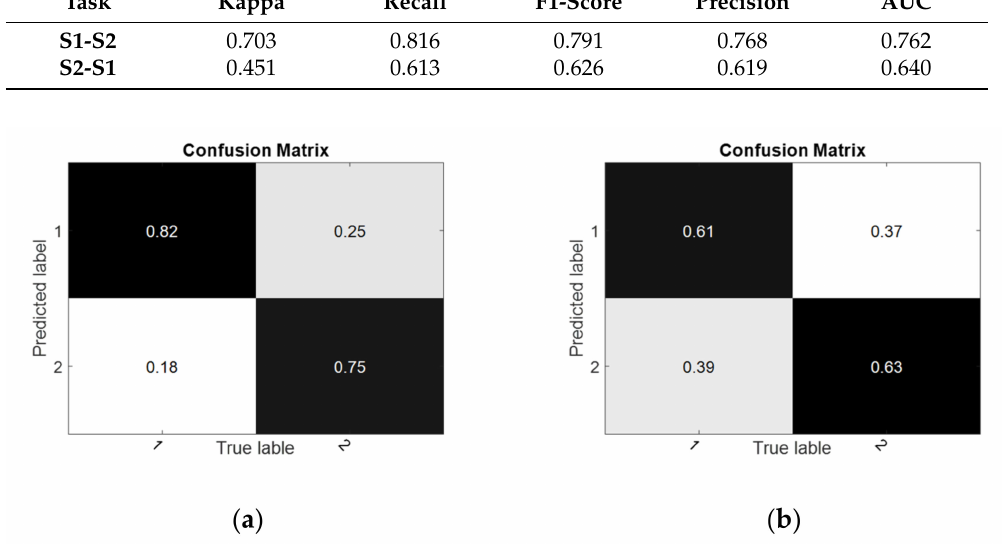
Figure 13. The confusion matrices of RF in the cross-subject experiment. ( a ) Random- NBI; ( b ) Random-BI.